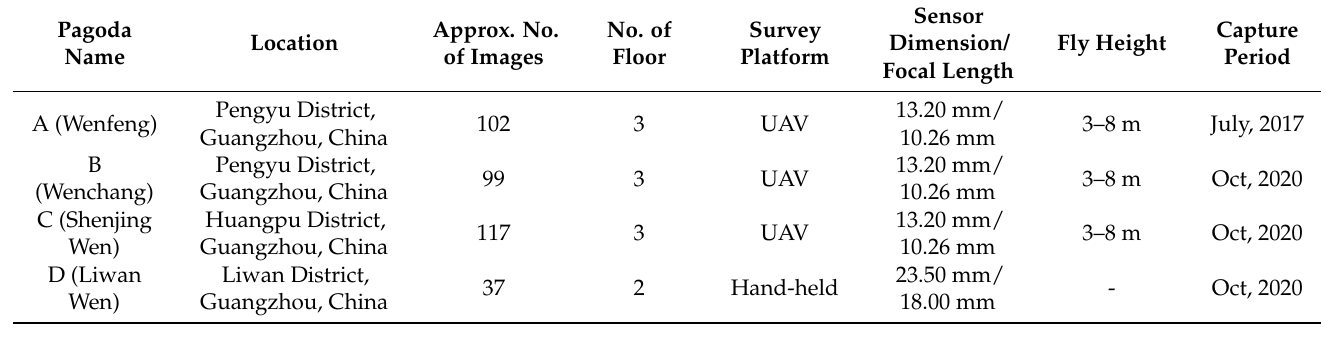
Table 1. Details of survey for the Pagoda A, B, C, and D.